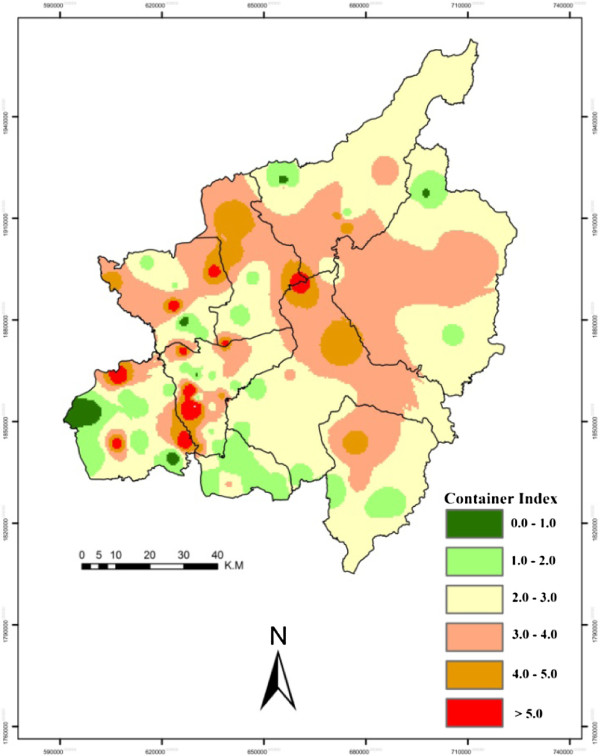
Province level container index (C.I.). This map is a visual presentation of C.I., i.e. the percentage of water holding containers infested with larvae, using interpolation techniques on the basis of sampled villages. The legend colors show the levels of C.I. from low (green) to high (red).